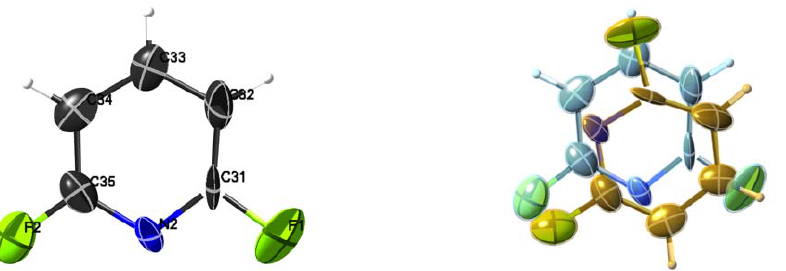
Figure 6. View of the 2,6-DFPy molecule in the crystal structure 5 along the molecular twofold axis ( left ) and along the lattice twofold axis ( − x , y , 1/2 − z ) ( right ). The 2,6-DClPy molecule in the crystal structure 4 is arranged in the same manner.